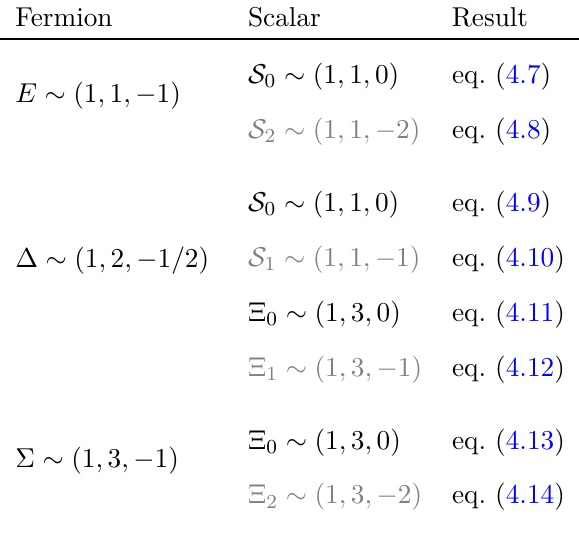
Table 2 . 2 field fermion-scalar UV extensions which generate the bridge topology with 3 heavy propagators. Completions in gray color involve fermion number violating